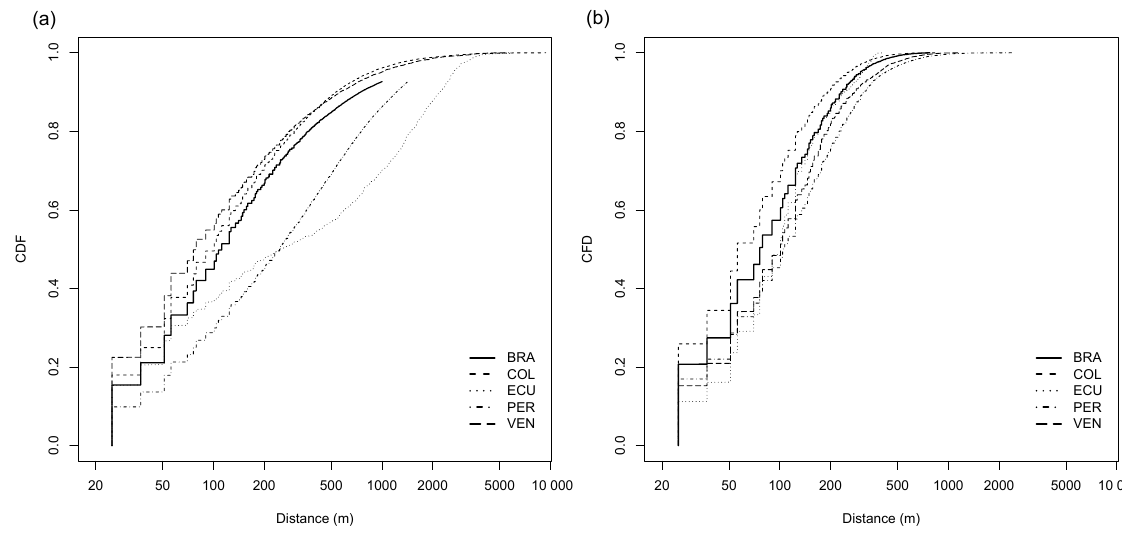
Figure 5. Cumulative frequency of the observed closest distance of fires to the forest edge occurring outside (a) and inside the forest (b) in 2010 for each